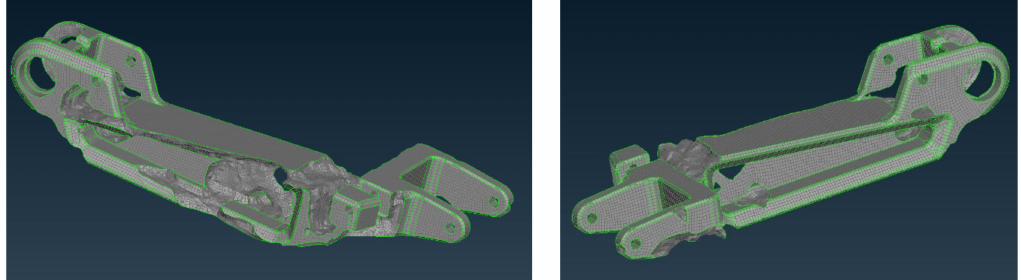
Figure 11. Topology optimization results for the